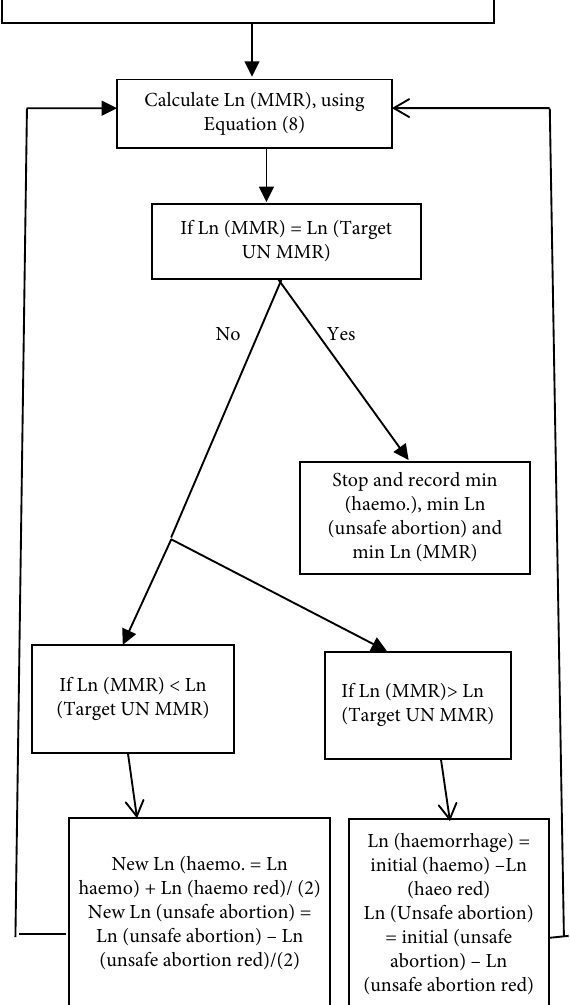
Figure 6: Calculation optimal min Ln (haemorrhaging) and min Ln (unsafe abortion) values for a given MMR